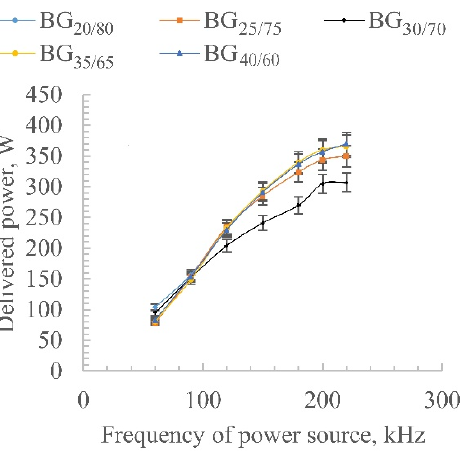
Figure 9. Graph of the energy consumption in accordance to the plasma frequency and BG concentration.